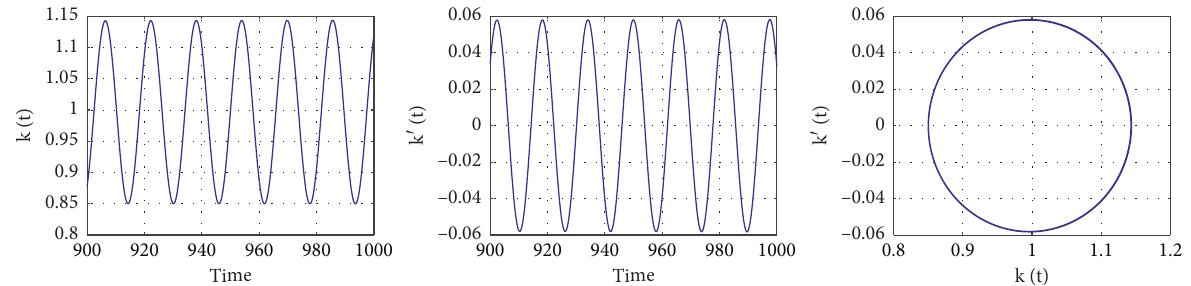
Figure 5: The birth of Hopf-bifurcated limit cycle from the fixed point k ∗ for the studied case when q � 0 . 75.